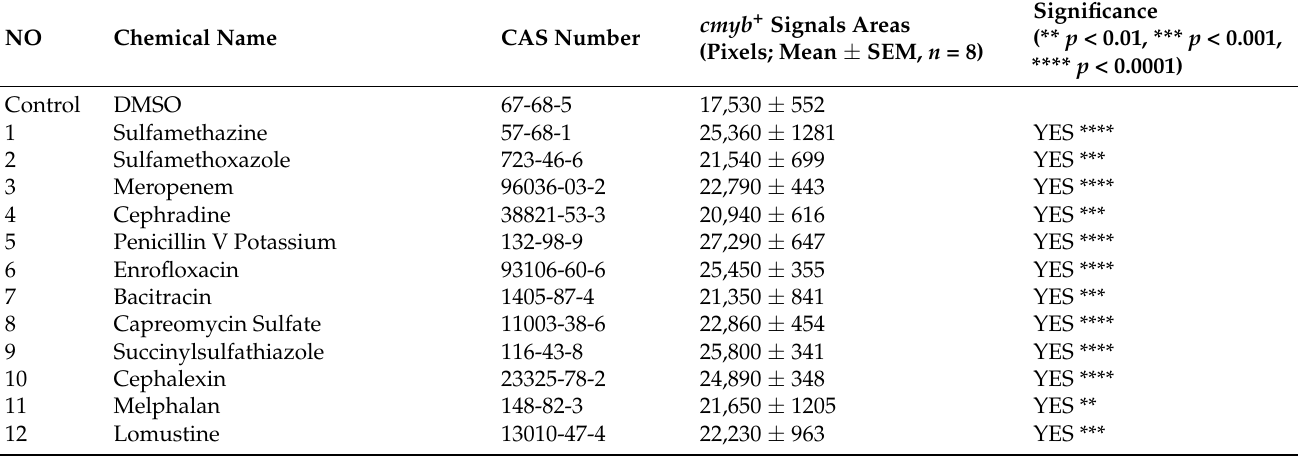
Table A1. Summary of cmyb + cell areas of in situ hybridization screening to search for chemicals able to expand HSPCs in zebrafish